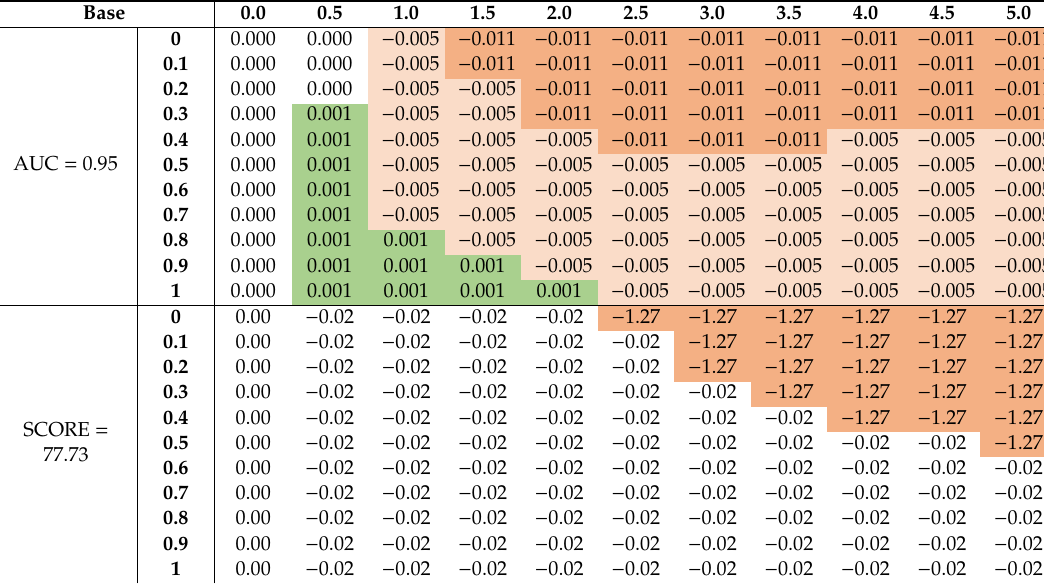
Table 5. Improvement of AUC and Score for Bradycardia on validation sample in terms of the α -parameter and p